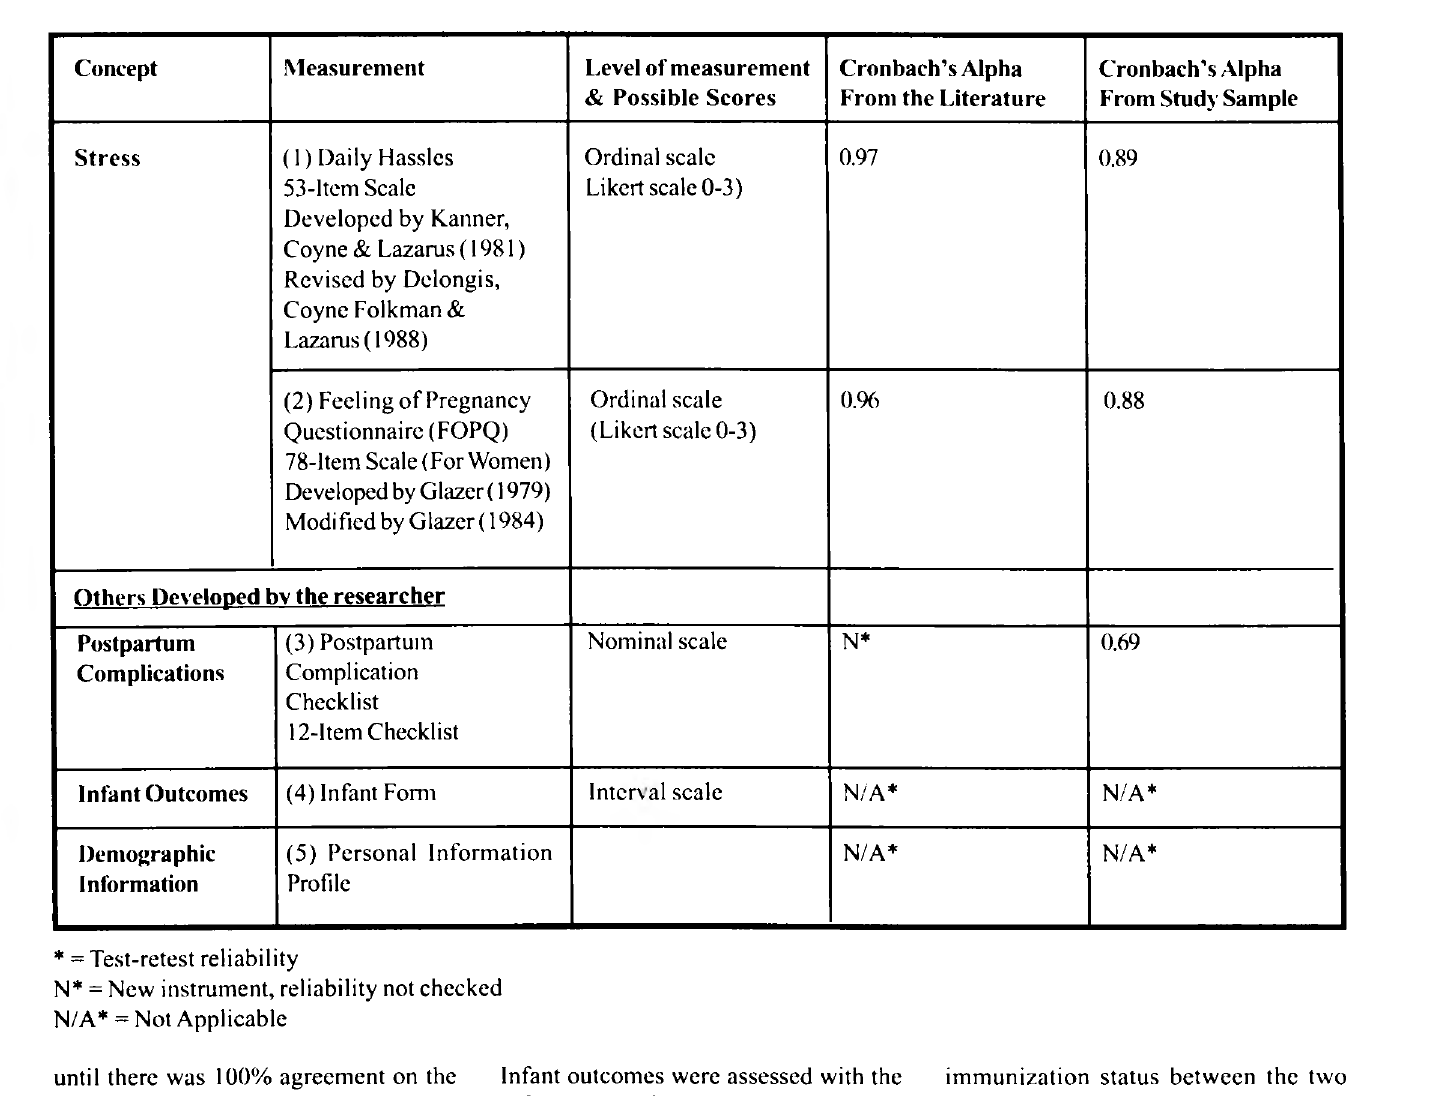
Table 1 A summary of the instruments and reliability